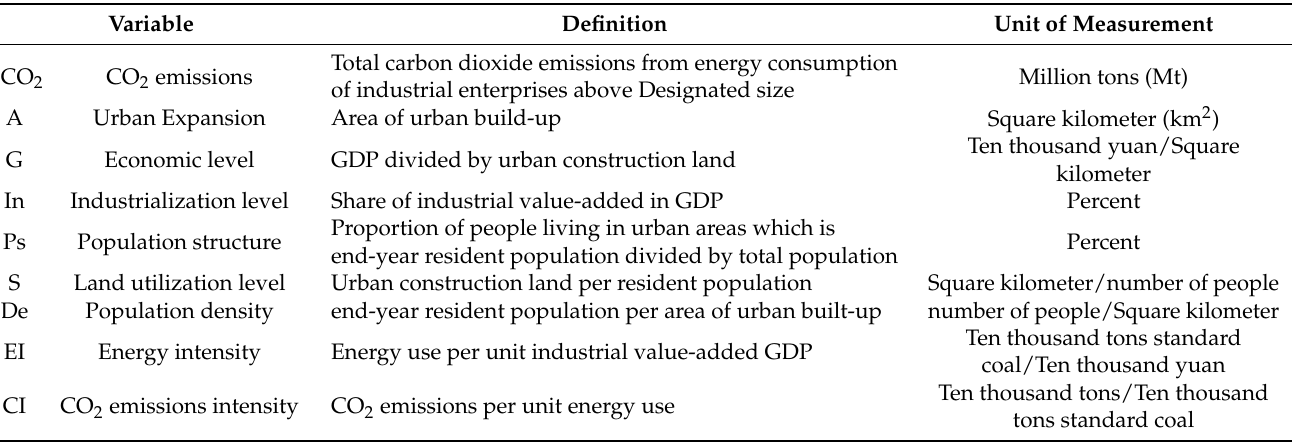
Table 1. Definition of variables used in this